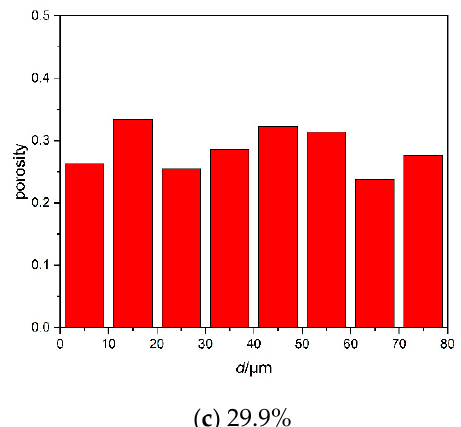
Figure 8. Pore space distribution of AP particles with different mass losses. The equivalent diameter of the pores was calculated using the maximum sphere method, and the variation process of the different pore size ratios with mass loss was an- alysed. Figure 9 shows the distribution of the pore equivalent diameter of AP particles with mass loss of 9.5%, 20.2% and 29.9%. At 9.5%, there were more small pores, and 31.7% of all pores were below 2 μ m. When the mass loss reached 20.2%, those below 2 μ m de- creased to 21.2%. When the mass loss reached 29.9%, the number of smaller pores was greatly reduced, and the pore distribution looks approximately Gaussian. The peak pore size was about 4 μ m.